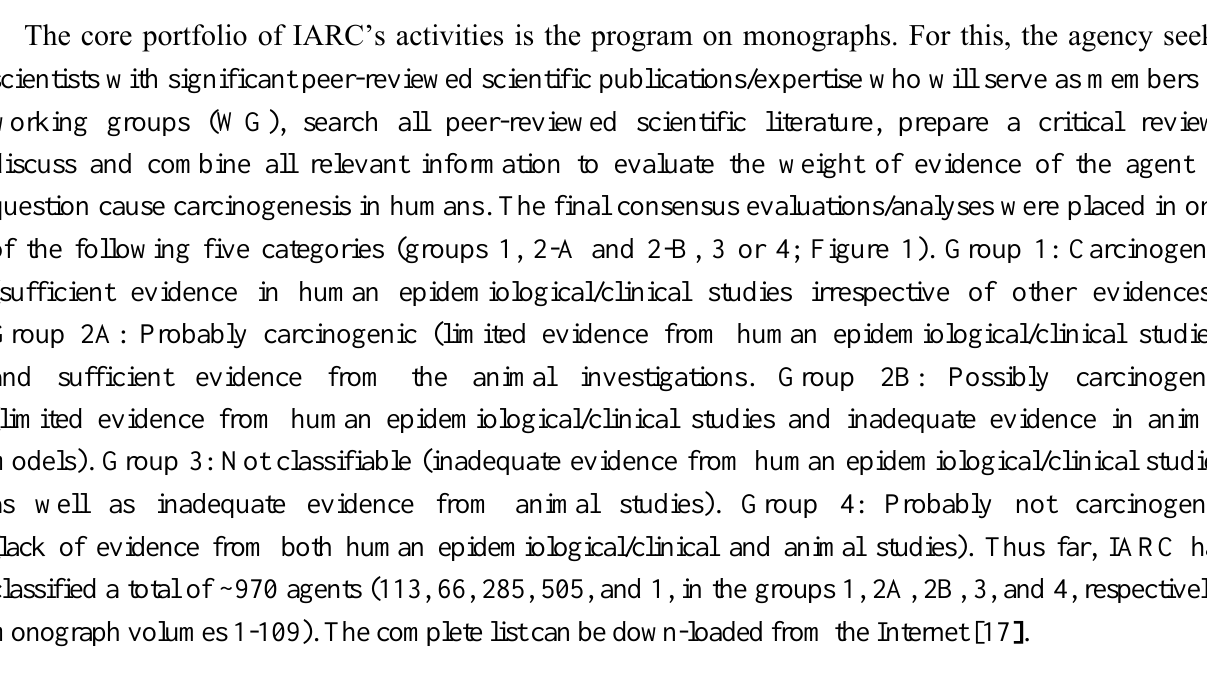
Figure 1. International Agency for Research on Cancer (IARC) classification of environmental agents in different categories, based on the “weight of scientific